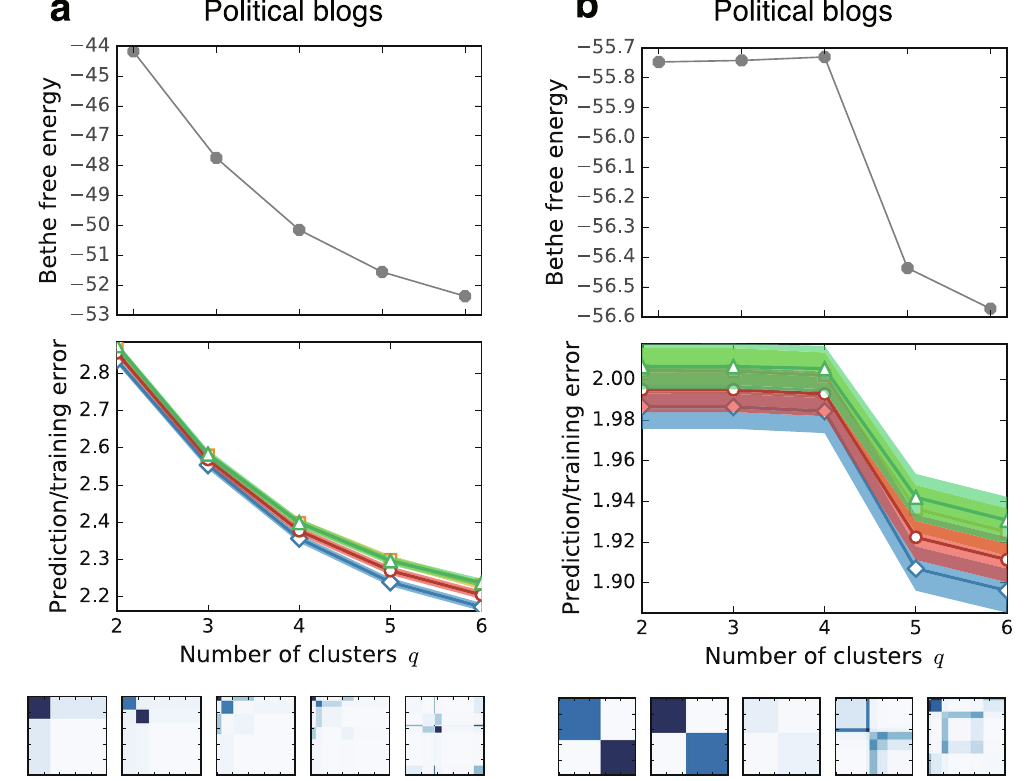
Figure 5. Results of the model assessments for the network of hyperlinks between blogs on US politics. ( a ) The results of the standard model and the learned parameters. ( b ) The results of the degree-corrected model and the learned